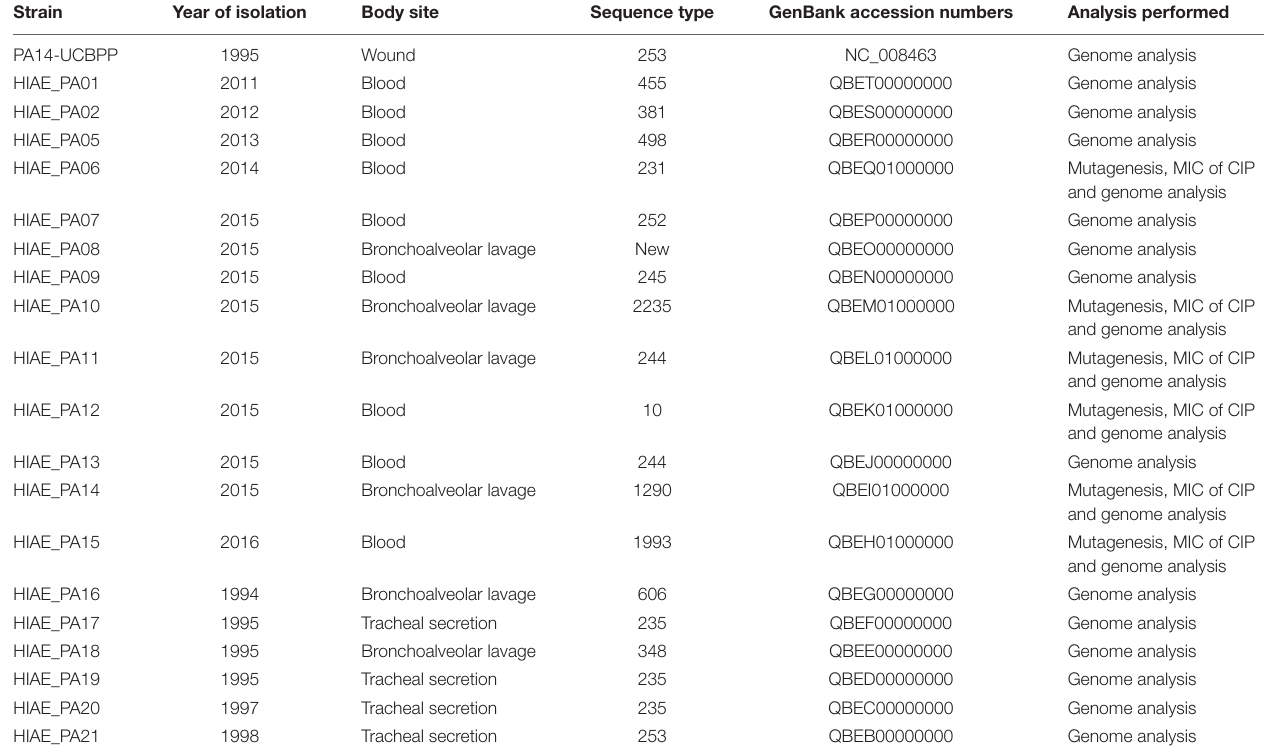
TABLE 1 | Clinical isolates and reference strain used in this study. Strain Year of isolation Body